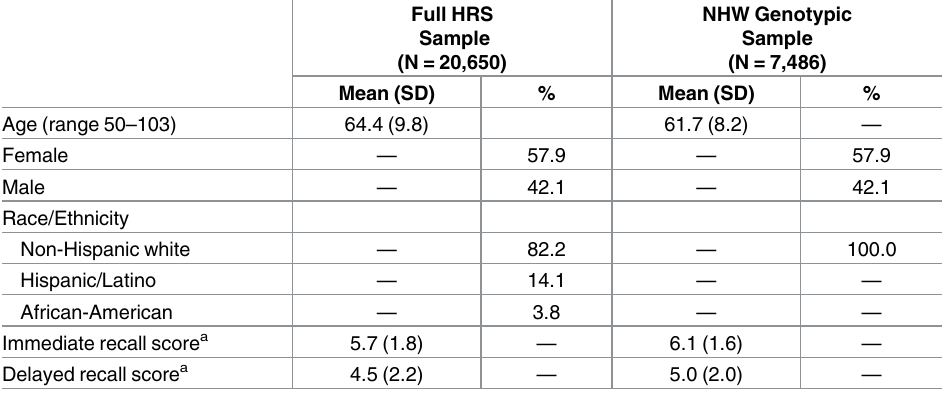
Table 1. Characteristics of HRS participants at the first assessmentpoint, tested for immediate and delayed recall between 1996 and 2012, in the HRS full and Non-Hispanic White (NHW) genotypic